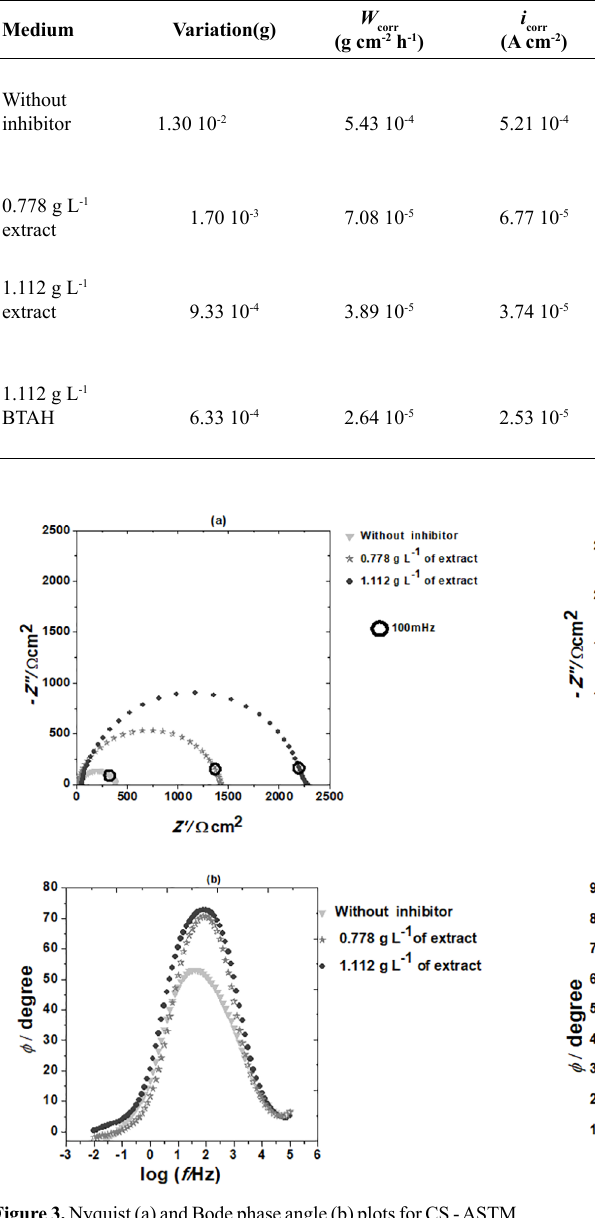
Figure 4. Nyquist (a) and Bode phase angle (b) plots for CS - ASTM 1020 after 90 min immersion in HCl 18.23 g L -1 in the absence and in the presence of 1.112 g L -1 of